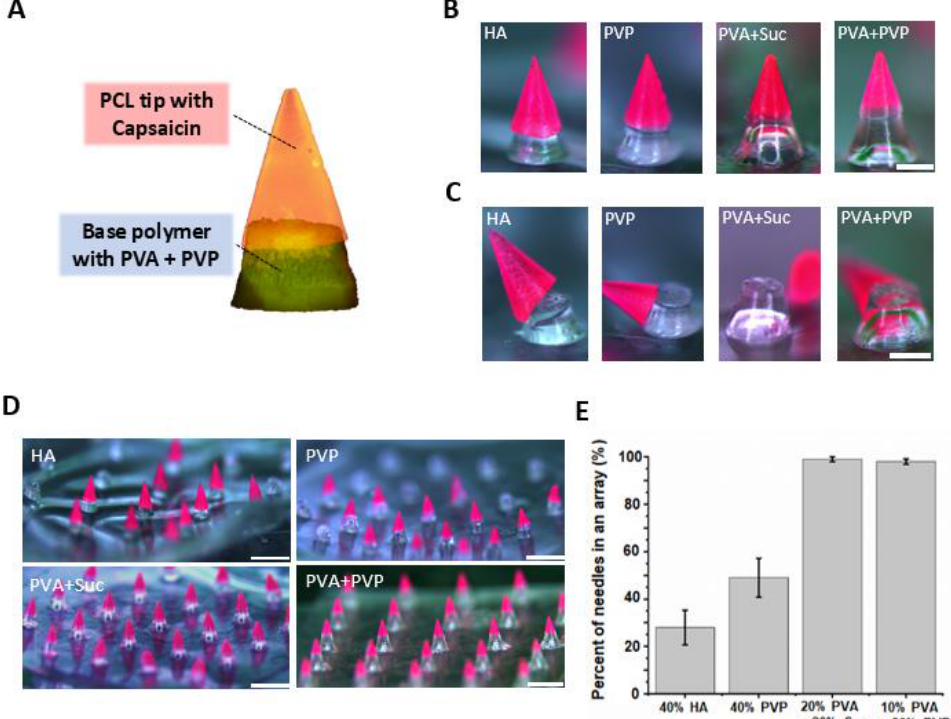
Figure 3. ( A ) Image of separable polycaprolactone (PCL) dissolving microneedles (SPCL-DMNs) with base polymer at the bottom; PCL contained 3% ( w / w ) Nile red, and the base polymer was composed of 40% ( w / v ) hyaluronic acid (HA) with 1 mg/mL calcein. ( B ) Fabricated SPCL-DMNs with four different base polymers, including 40% ( w / v ) HA, 40% ( w / v ) polyvinylpyrrolidone (PVP), 20% ( w / v ) polyvinyl alcohol (PVA) with 20% ( w / v ) sucrose, and 10% ( w / v ) PVA with 20% ( w / v ) PVP, and PCL containing 3% ( w / w ) Nile red for visible separation of PCL and base polymer (scale bar: 250 µ m). ( C ) Separation images of each fabricated SPCL-DMN candidates by lateral force (scale bar: 250 µ m). ( D ) SPCL-DMNs patch images with four different base polymers: 40% ( w / v ) HA, 40% ( w / v ) PVP, 20% ( w / v ) PVA with 20% ( w / v ) sucrose, and 10% ( w / v ) PVA with 20% ( w / v ) PVP after peeling-off process (scale bar: 1 mm). ( E ) Percentage of fabricated needles out of 5 × 5 arrays with four different base polymers ( n = 4, mean ± SEM).